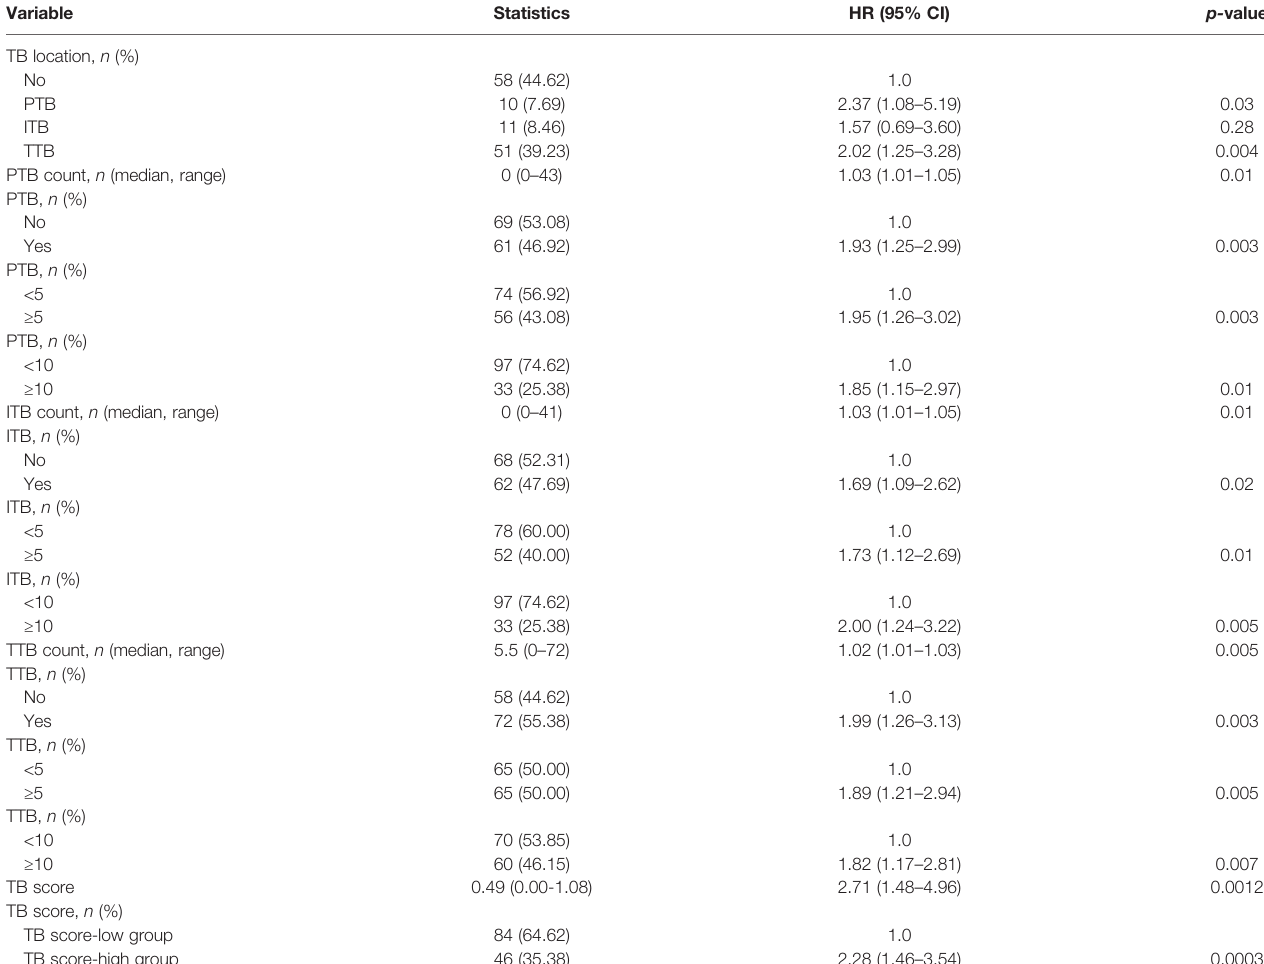
TABLE 3 | Results of the univariate analysis between tumor budding and overall survival. Variable